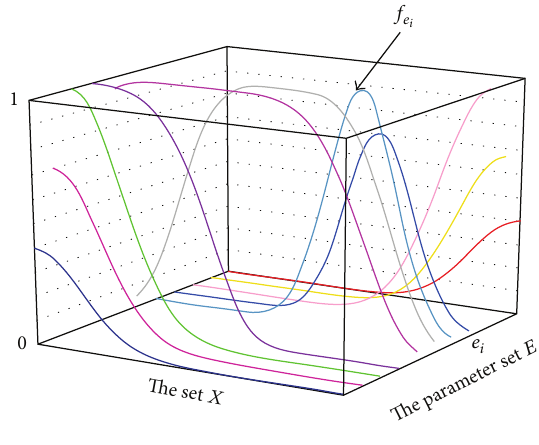
Figure 1: A fuzzy soft set 𝑓